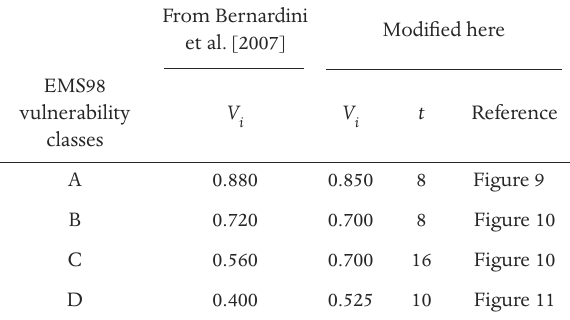
and t parameters ac- i